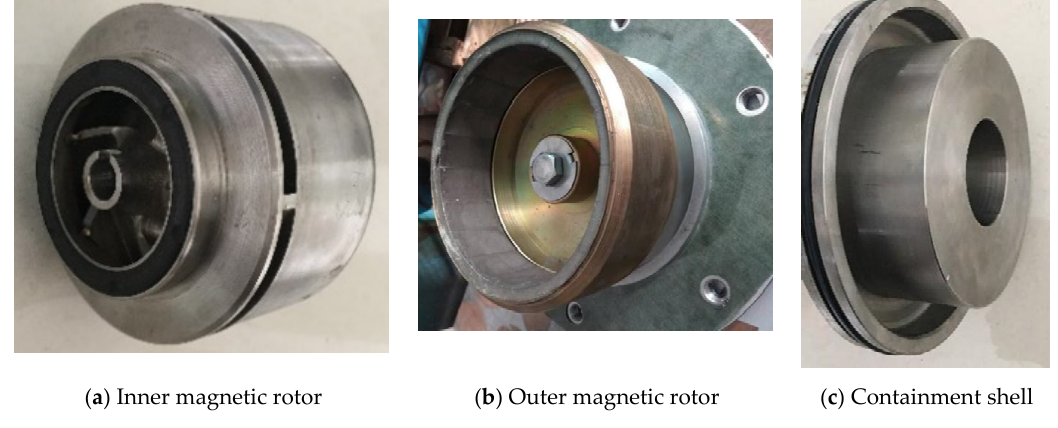
Figure 3. Parts of the magnetic coupling. Table 2. Geometric parameters of the magnetic coupling.